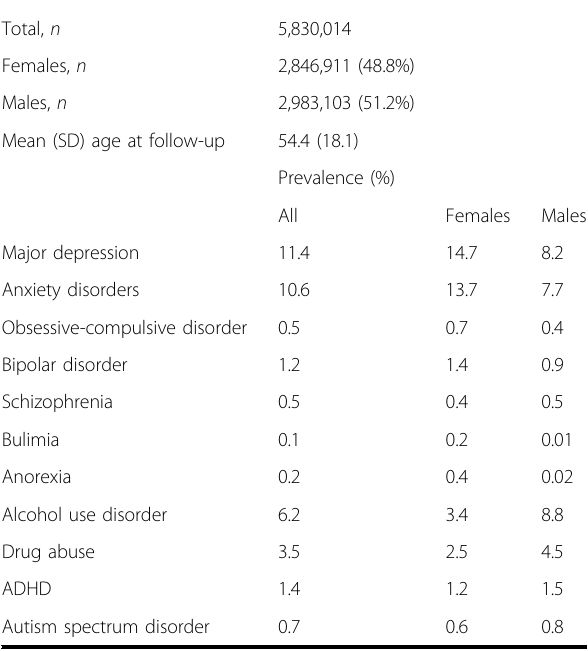
Table 1 Descriptive features of our population cohort and case